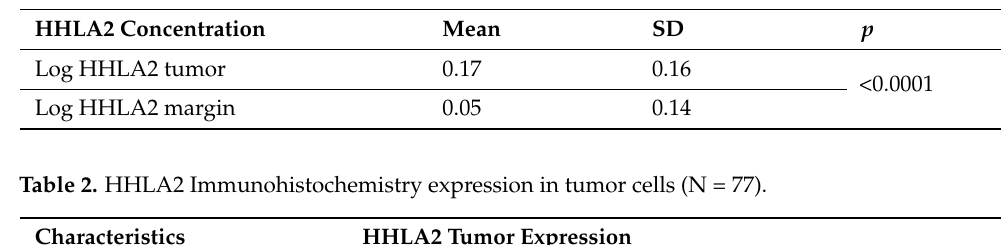
Table 1. HHLA2 concentrations in tumor and margin [pg/mL], N = 167. Paired T-test.